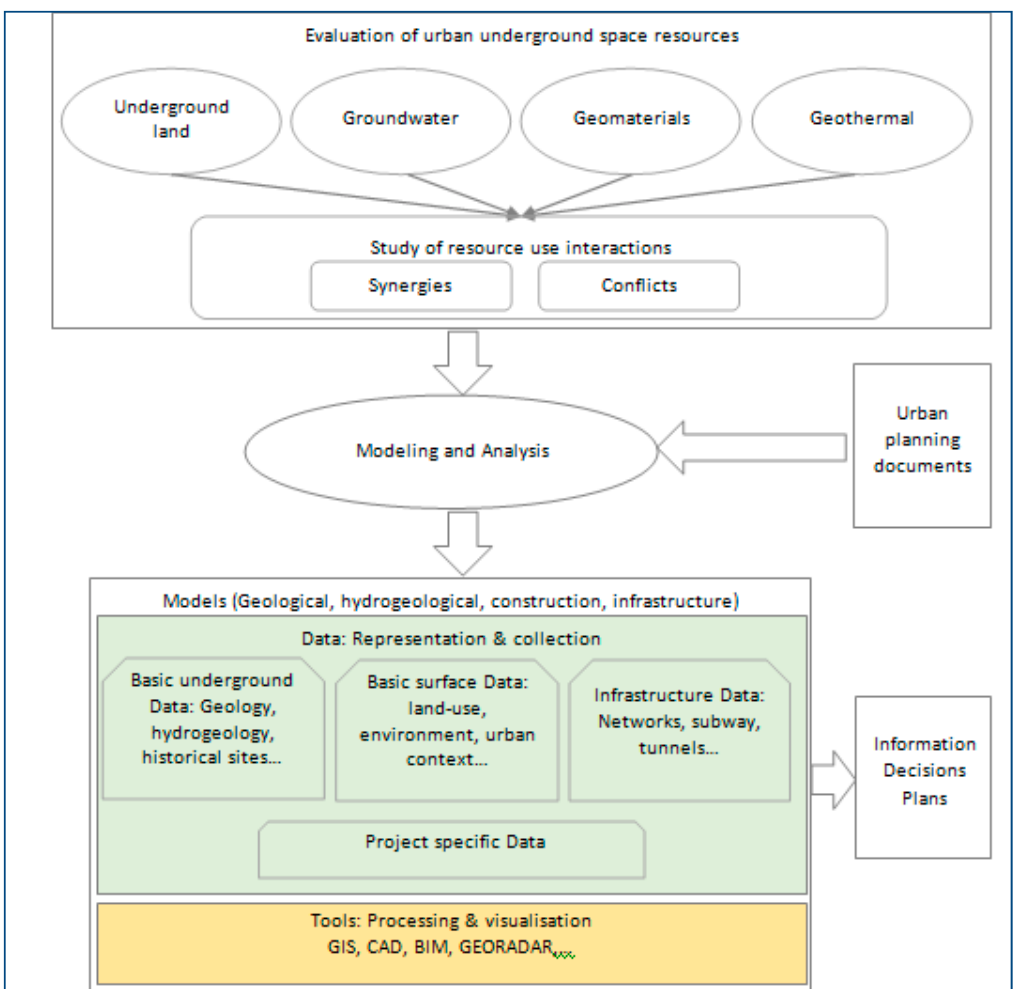
Figure 10. The structure of Sub-Urban Information Modeling (SURBIM).